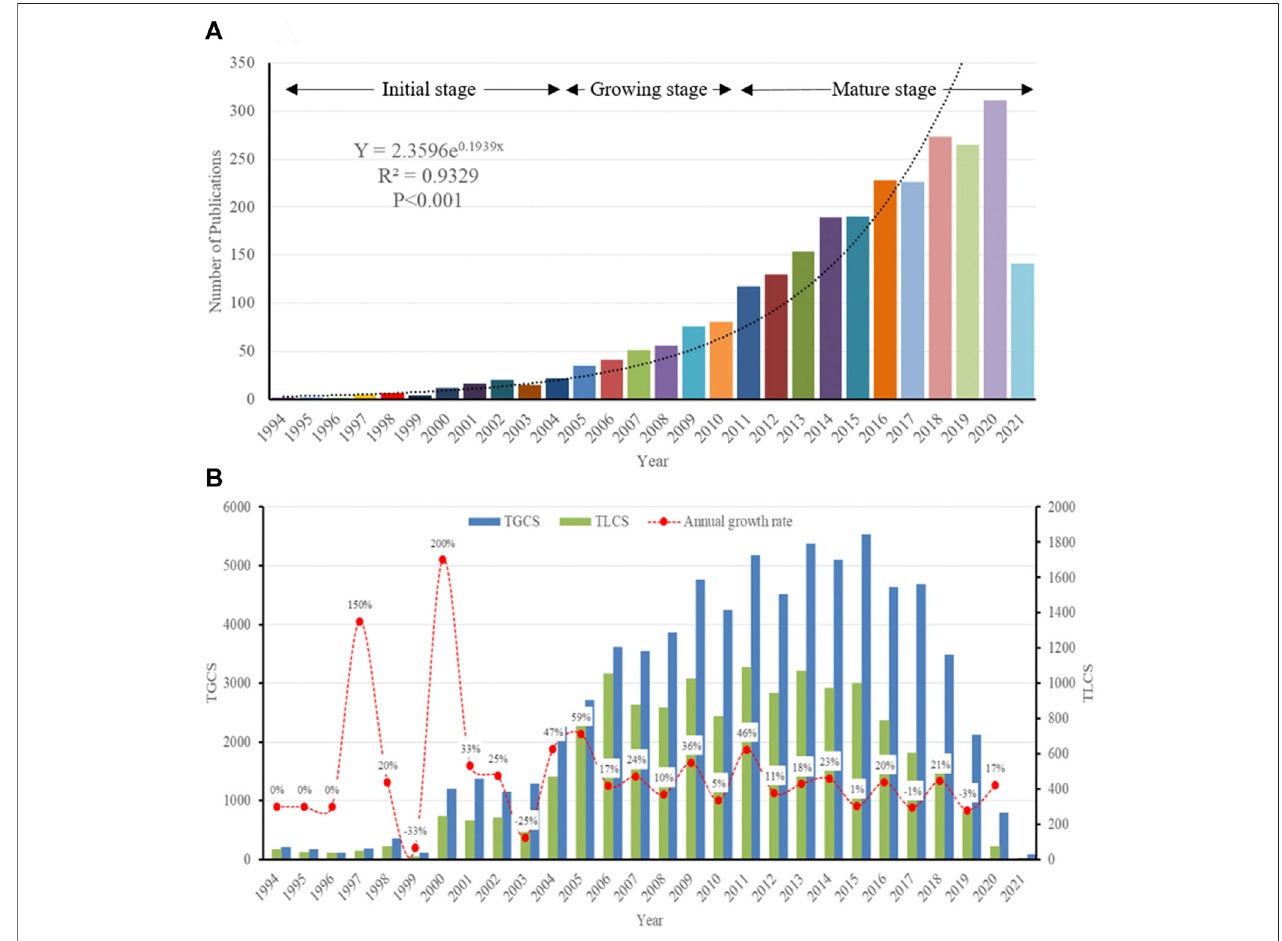
FIGURE1| OverallDistribution ofpublication outputson podocyte injury (A) Global annual outputtrends; (B) TGCS, TLCS and growth rate inannual publications.